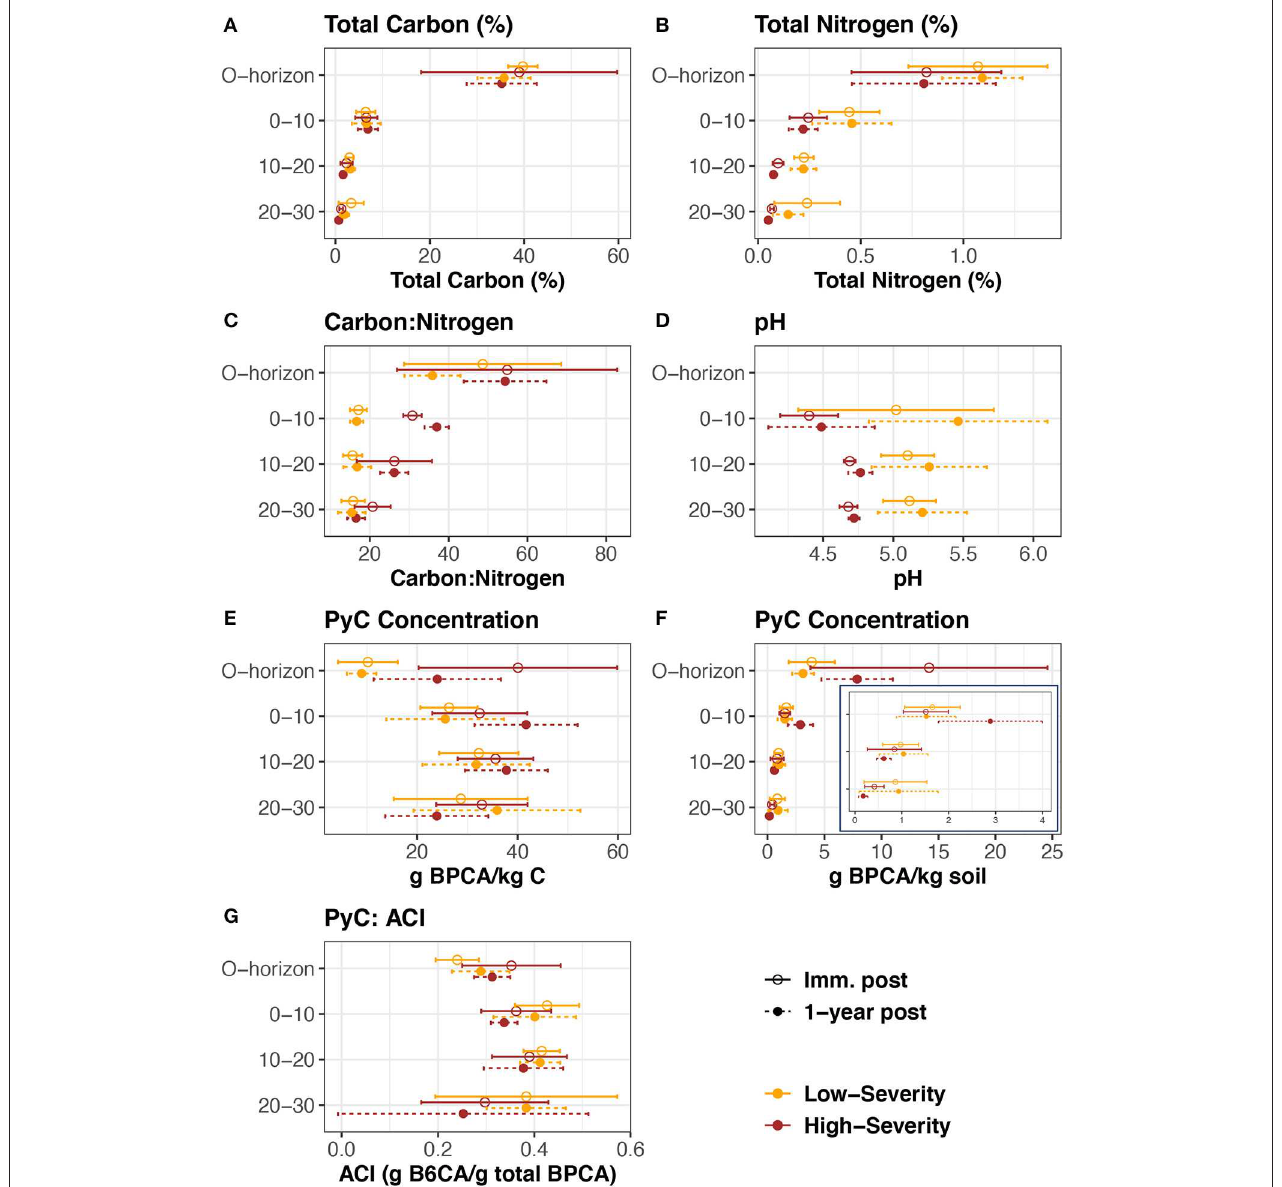
FIGURE 4 | (A) Total carbon, (B) total nitrogen, (C) C:N, (D) pH, (E) PyC concentration normalized by total carbon, (F) PyC concentration normalized by soil mass, and (G) ACI for grab samples collected from distributed plots that burned with lower severity and higher severity during the Chimney Tops 2 Fire. Inset in (F) of the PyC concentration of mineral soil horizons. Circles denote mean values, error bars denote standard